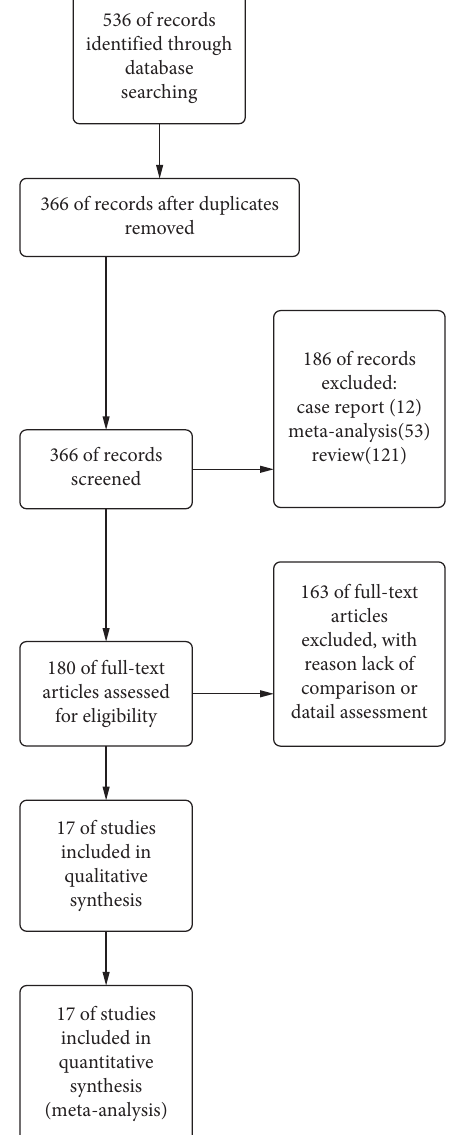
Figure 2: Flowchart of literature